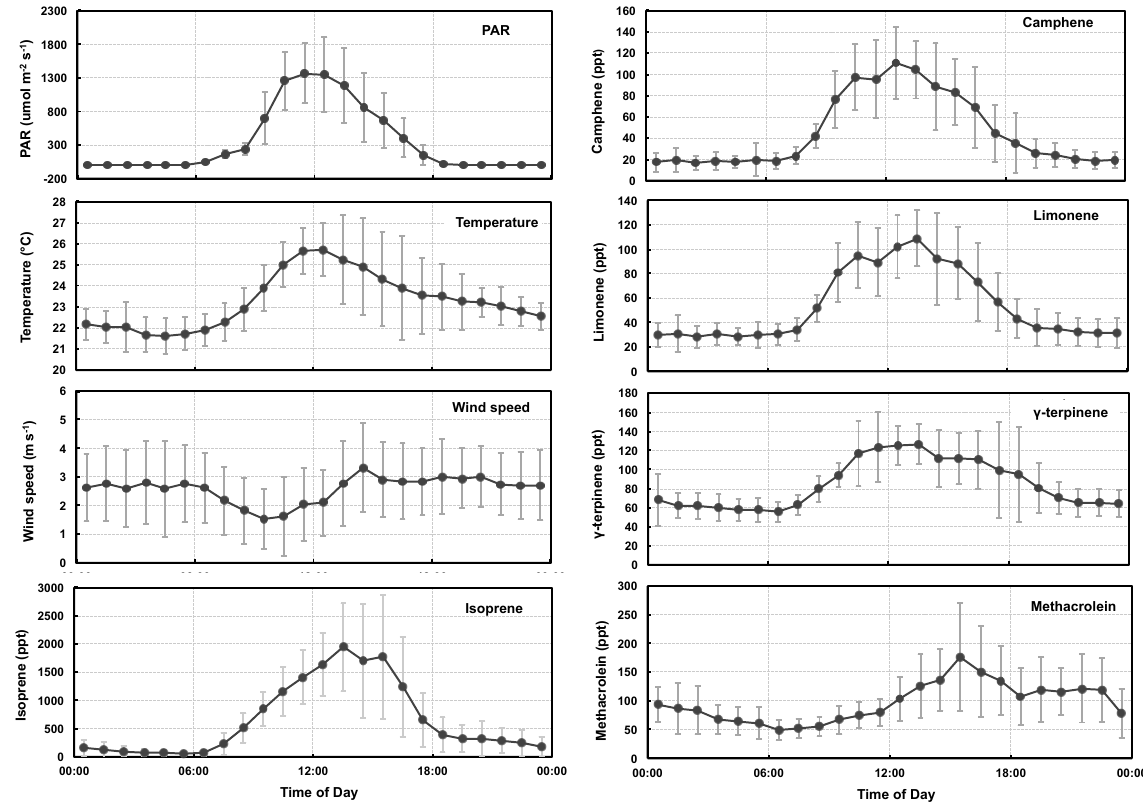
Fig. 3. Diurnal average PAR and temperature profiles and mixing ratios of isoprene, the three most abundant monoterpenes (limonene, γ -terpinene and camphene) and methacrolein. Note PAR, temperature and wind speed measurements correspond to a height of 75m.